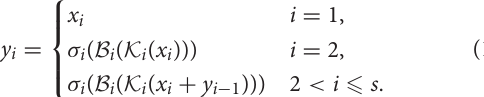
operation on each subset x i can be expressed as: σ i ( B i ( K i ( x i